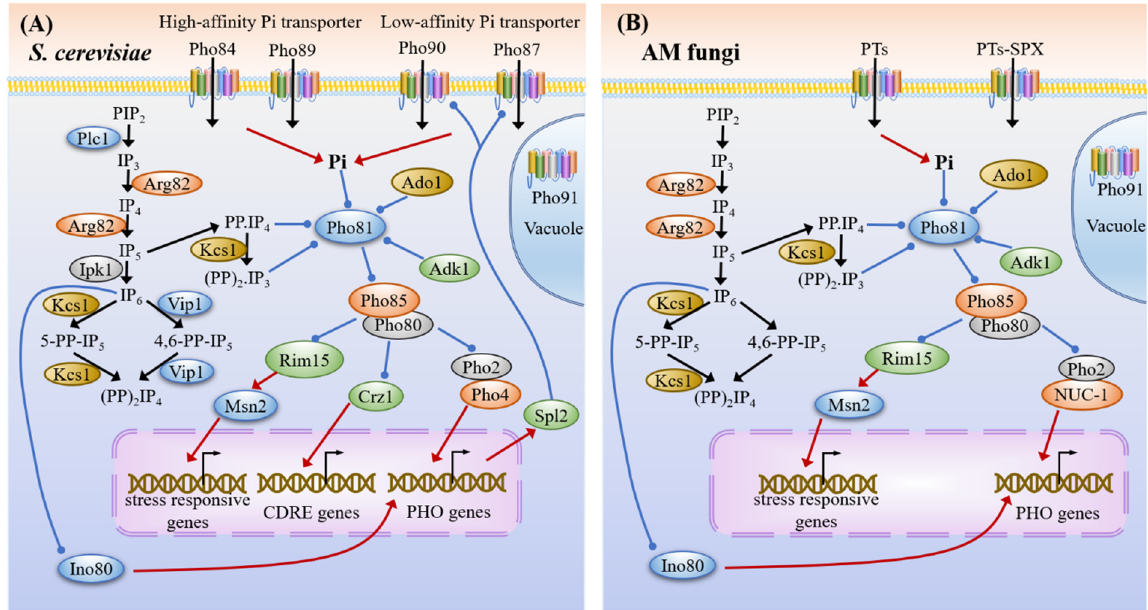
Figure 5. PHO signaling pathways in yeast ( A ) and AM fungi ( B ). The phosphate transporters take up the external phosphate into AM fungi. The inositol-polyphosphate kinase Arg82 and inositol hexakisphosphate (IP 6 ) kinase Kcs1 involved in the inositol phosphate metabolism can mediate the increase of IP 7 , which is in response to low phosphate and functions upstream of Pho81, a mediator of intracellular phosphate sensing in the PHO pathway. The adenylate kinase Adk1 and adenosine kinase Ado1 affect IP 7 synthesis and function upstream of Pho81 to negatively regulate the expression of PHO genes. The interaction between IP 7 and Pho81 induces the formation of the Pho81 and Pho85-Pho80 tri-complex, resulting in the nuclear localization of the transcriptional activator NUC-1 (Pho4 homolog) with cofactor Pho2. Subsequently, the downstream of genes involved in the PHO pathway is transcriptionally activated under phosphate limitation. Under high phosphate conditions, the SPX domain-containing phosphate transporters PTs in AM fungi (e.g., RiPT7 in R. irregularis and GigmPT6/7 in G. margarita , homologs of Pho87/90 in yeast) are responsible for the phosphate transport and homeostasis. The phosphorylation of NUC-1 by the Pho85-Pho80 complex and its export by Msn5 out of the nucleus cause the repression of the PHO pathway. Ino80, whose ATPase activity is inhibited by IP 6 , is required for the regulation of chromatin remodeling and transcription, including the expression of some PHO genes. The homologs of SPX domain-containing proteins PTs-SPX can regulate phosphate homeostasis at arbuscular mycorrhizas, while the vacuolar transporter chaperones (VTCs) and polyphosphatases Ppn1 and Ppx1 can regulate vacuolar polyphosphate metabolism. The proteins Plc1, Ipk1, Spl2 and Crz1 are not found in the genomes of AM fungi. The red lines with the arrows indicate facilitation, whereas the blue lines with the dots indicate inhibition and the black arrows represent translocation or transformation.